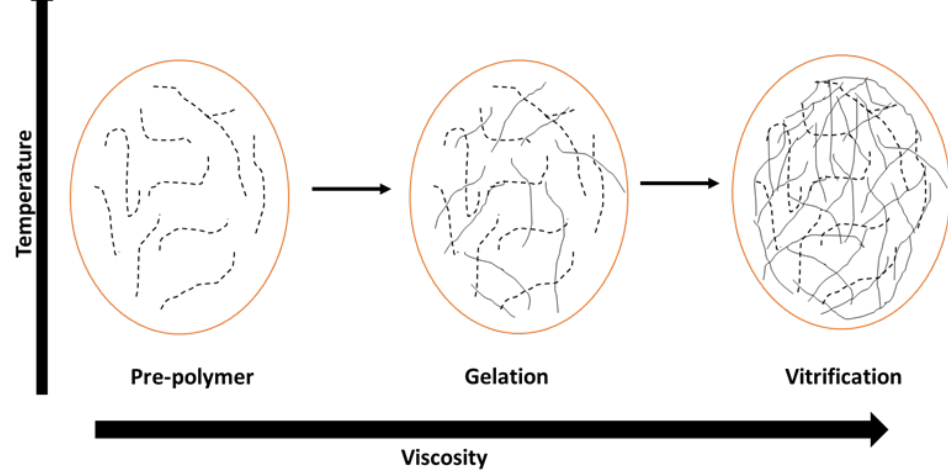
Figure 13 . The cure diagram of a resin vitrification process [125]. Figure 13. The cure diagram of a resin vitrification process